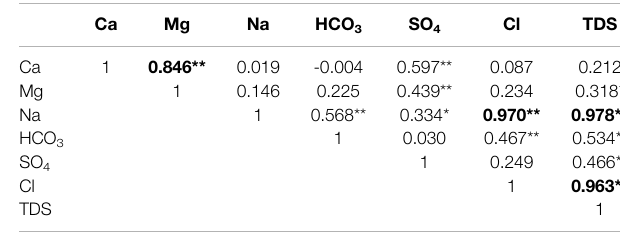
TABLE 2 | Pearson correlation matrix of the major chemical parameters in groundwater.